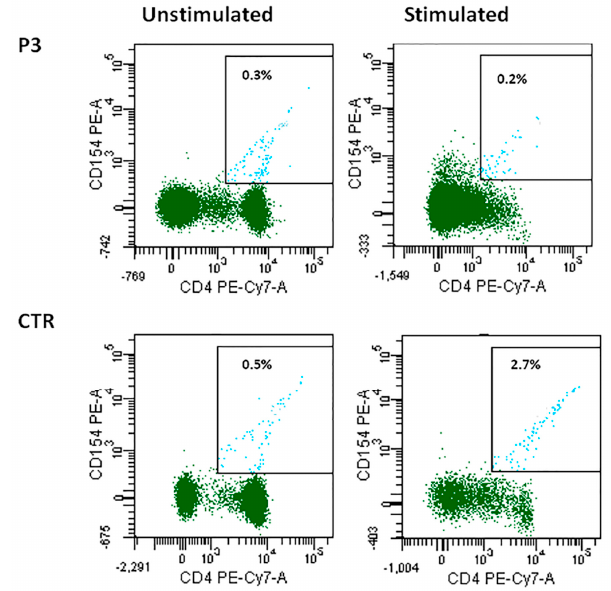
Figure 3. CD40L expression in patient P3 unstimulated and stimulated CD4 + cells as compared with the